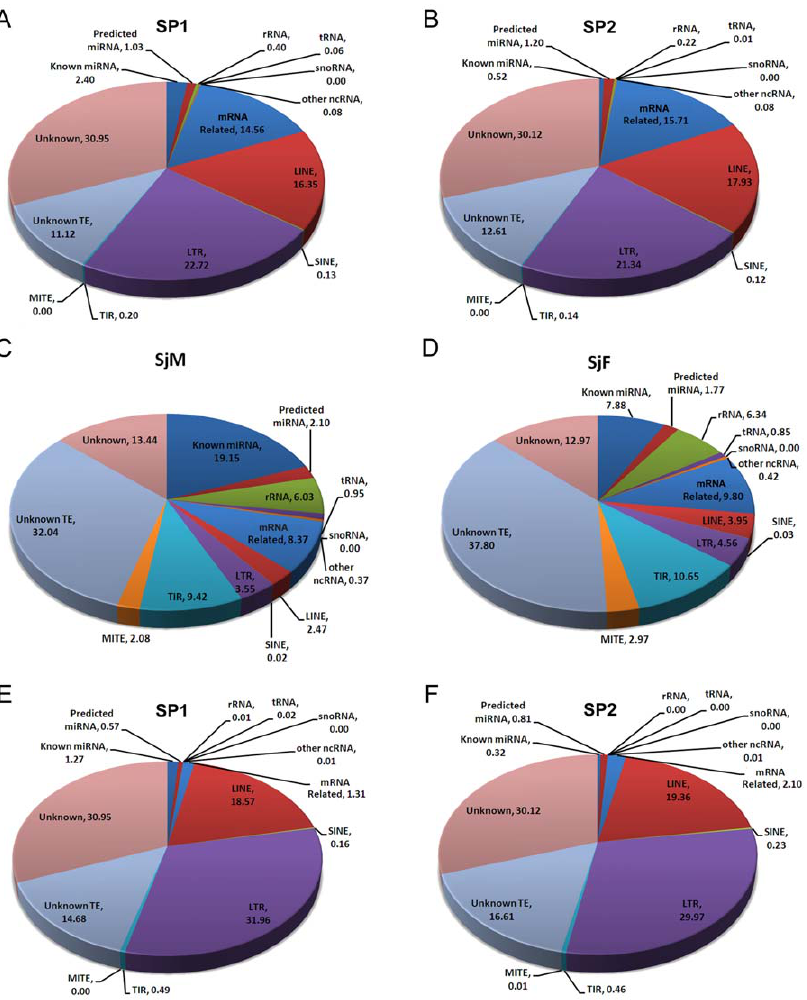
Figure 5. Classification and percentage of small non-coding RNAs in different libraries. A. Classification of small RNAs in the SP1 and B. SP2 libraries using the bioinformatic pipeline described in [18]. C. Small RNA classification of the SjM and D. SjF libraries using the data from our previous study [18]. E. Small RNA classification of the SP1 and F. SP2 libraries using an alternative bioinformatic pipeline as described in the Materials and